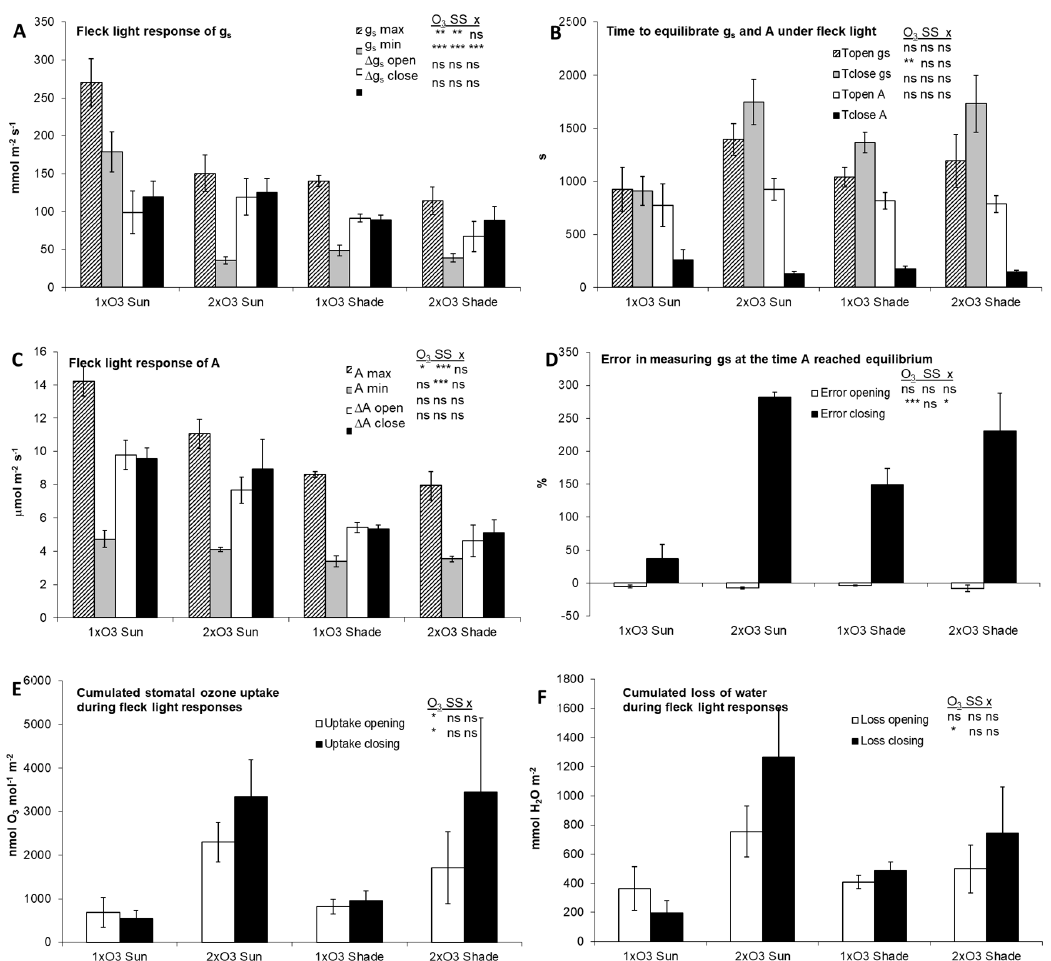
Figure 4. Summary of stomatal and assimilatory responses to fleck light in beech ( ± SE): ( A ) max and min stomatal conductance (gs) and span of gs variation ( ∆ ); ( B ) time gs and A reached equilibrium when stomata closed and opened (T); ( C ) max and min photosynthesis (A) and span of A variation ( ∆ ); ( D ) error in measuring gs at the time A reached equilibrium when stomata closed and opened (error); ( E ) relative stomatal ozone uptake during opening and closing (uptake); ( F ) relative water loss during opening and closing (loss). The insets show the results of a two-way (O 3 regime x Sun / Shade leaf) ANOVA: ns, p > 0.05; *, p < 0.05; **, p < 0.01; ***, p < 0.001. Each bar is the average of two cycles on six leaves ( n =